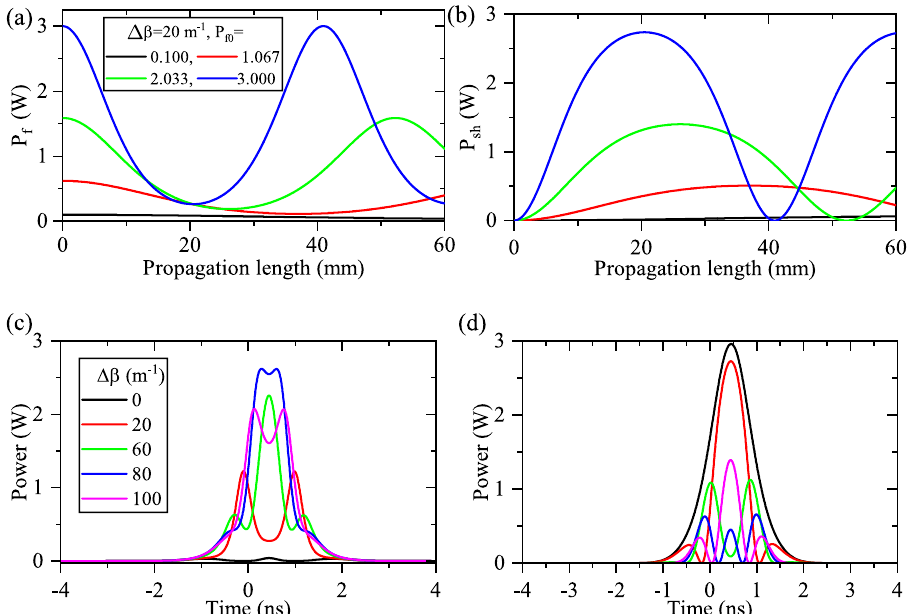
Figure 2. Power evolution of fundamental ( a ) and SH ( b ) modes in a waveguide (L = 60 mm) with constant 1 phase mismatch �β = 20m − , when different coupled fundamental powers ( P f 0 = 0.100, 1.067, 2.033, 3.00 W) are considered. The output pulse shape of fundamental ( c ) and SH ( d ) modes with different values of 1 constant phase mismatch ( �β = 0, 20, 60, 80 , and 100 m − ). Because of the periodic depletion of fundamental 2 and SH powers, their final shapes are changed from sech one, more